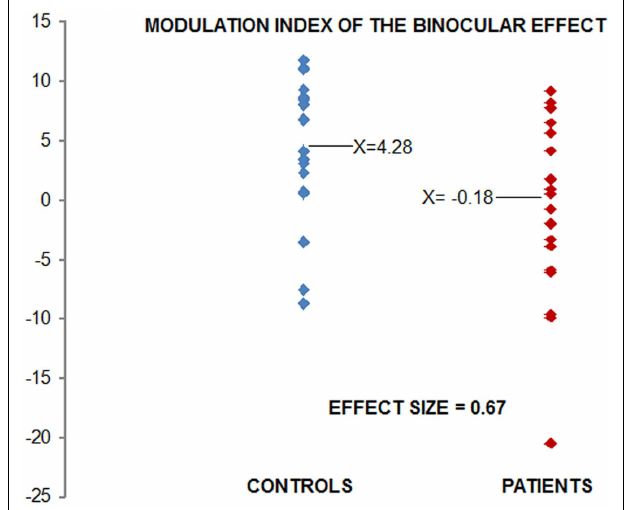
FIGURE 4 | Scatter plot is displayed showing correlations for each subject of P1 amplitude to modulation index .The x -axis displays values for P1 amplitudes; y -axis displays binocular modulation indices. The P1 values used here are collapsed averages of left and right hemiscalp amplitudes. Controls are depicted by blue points ( n = 16), patients by pink ( n = 16).